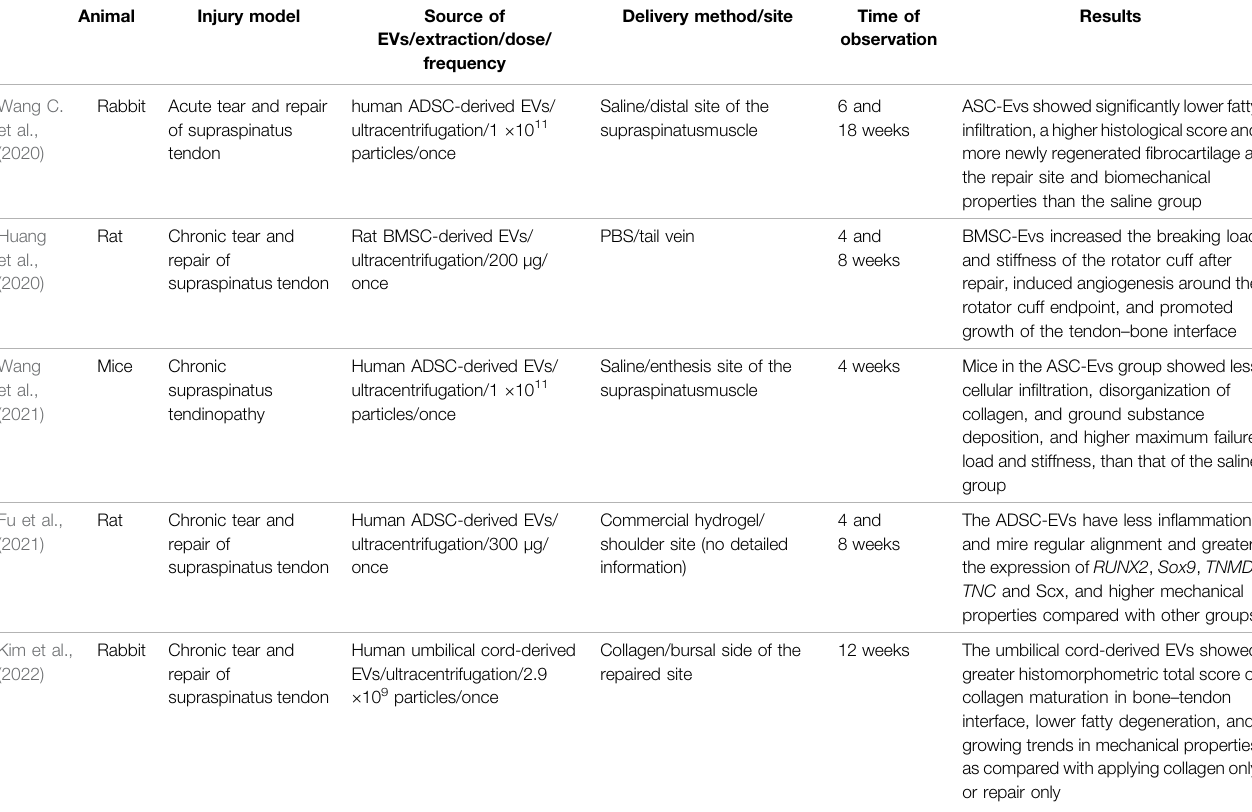
TABLE 3 | Summary of extracellular vesicles from mesenchymal stem cells for the repair of rotary cuff injuries.